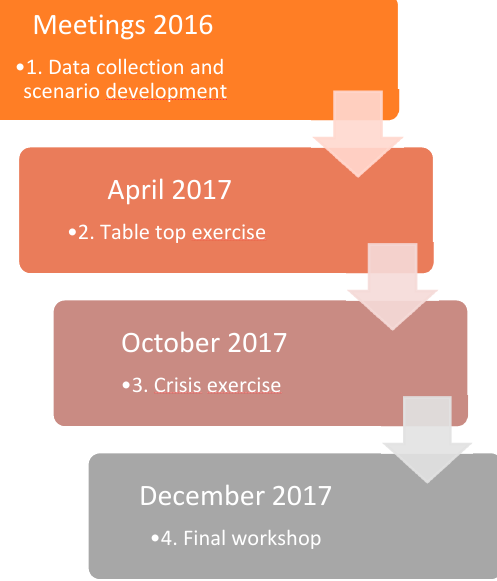
Figure 3. User engagement process.